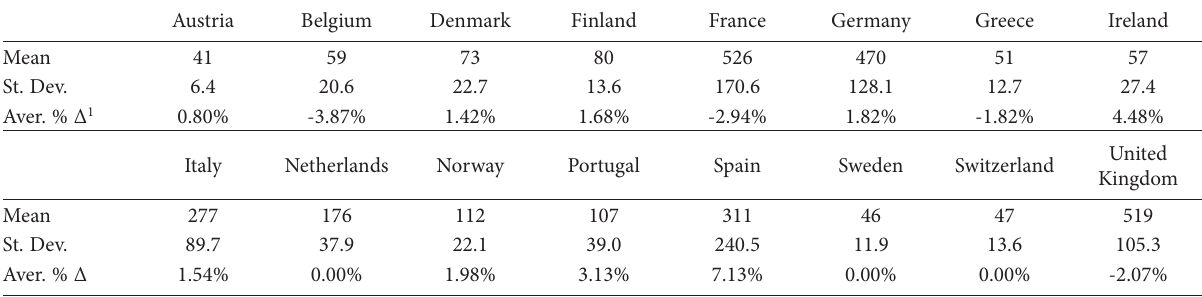
Table 1. GBAORD for agriculture – Million 2005 Dollars – Constant prices and PPPs (time